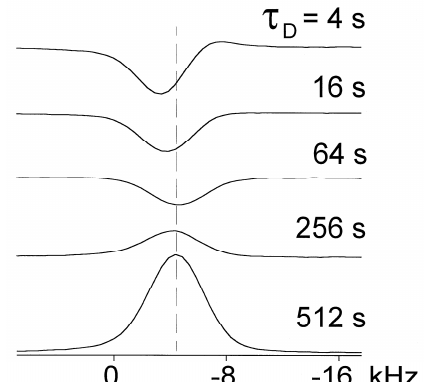
Figure 8. Dependence of the 31 P optically-pumped nuclear magnetic resonance (NMR) lineshape on the period during which the shutter is closed τ D , with the period during which the shutter is open τ = 120 s. At short τ D , the lineshape is dominated by signal from the optically-pumped surface-layer. At long τ D , the lineshape is dominated by signal from the bulk of the InP sample which increases due to spin-lattice relaxation. (Reprinted from Reference [31], © (1998), with permission from Elsevier).